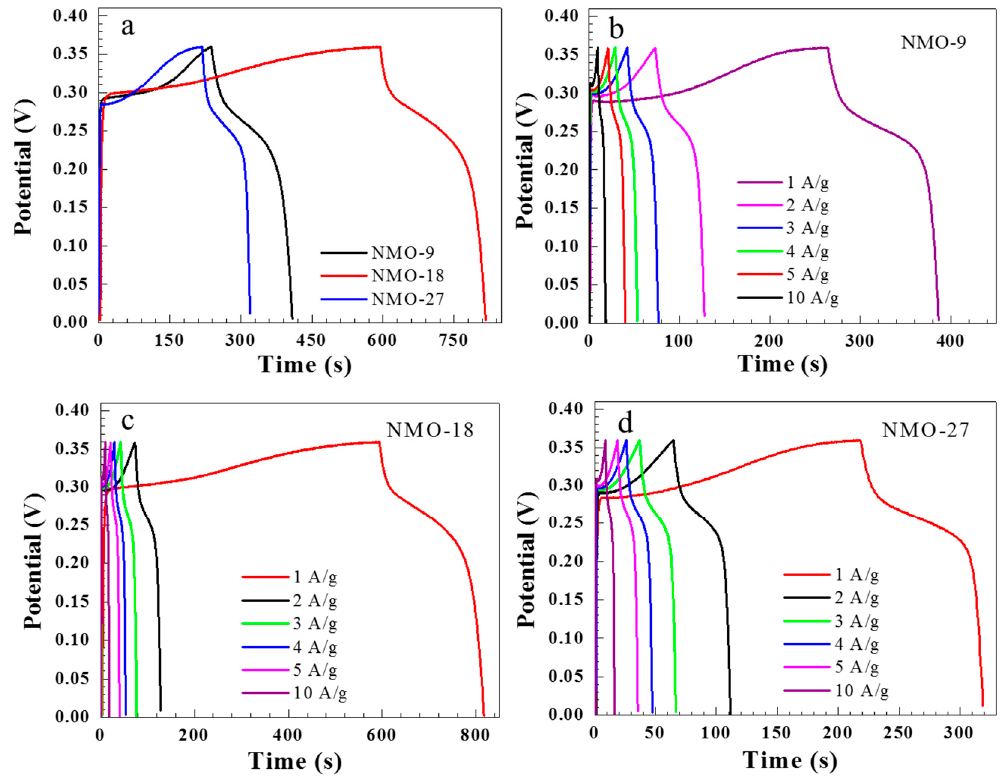
Figure 5. Galvanostatic charge-discharge profile for ( a ) NMO-9, NMO-18, and NMO-27 at 1 A/g current density; ( b ) NMO-9; ( c ) NMO-18; and ( d ) NMO-27 at various current densities.